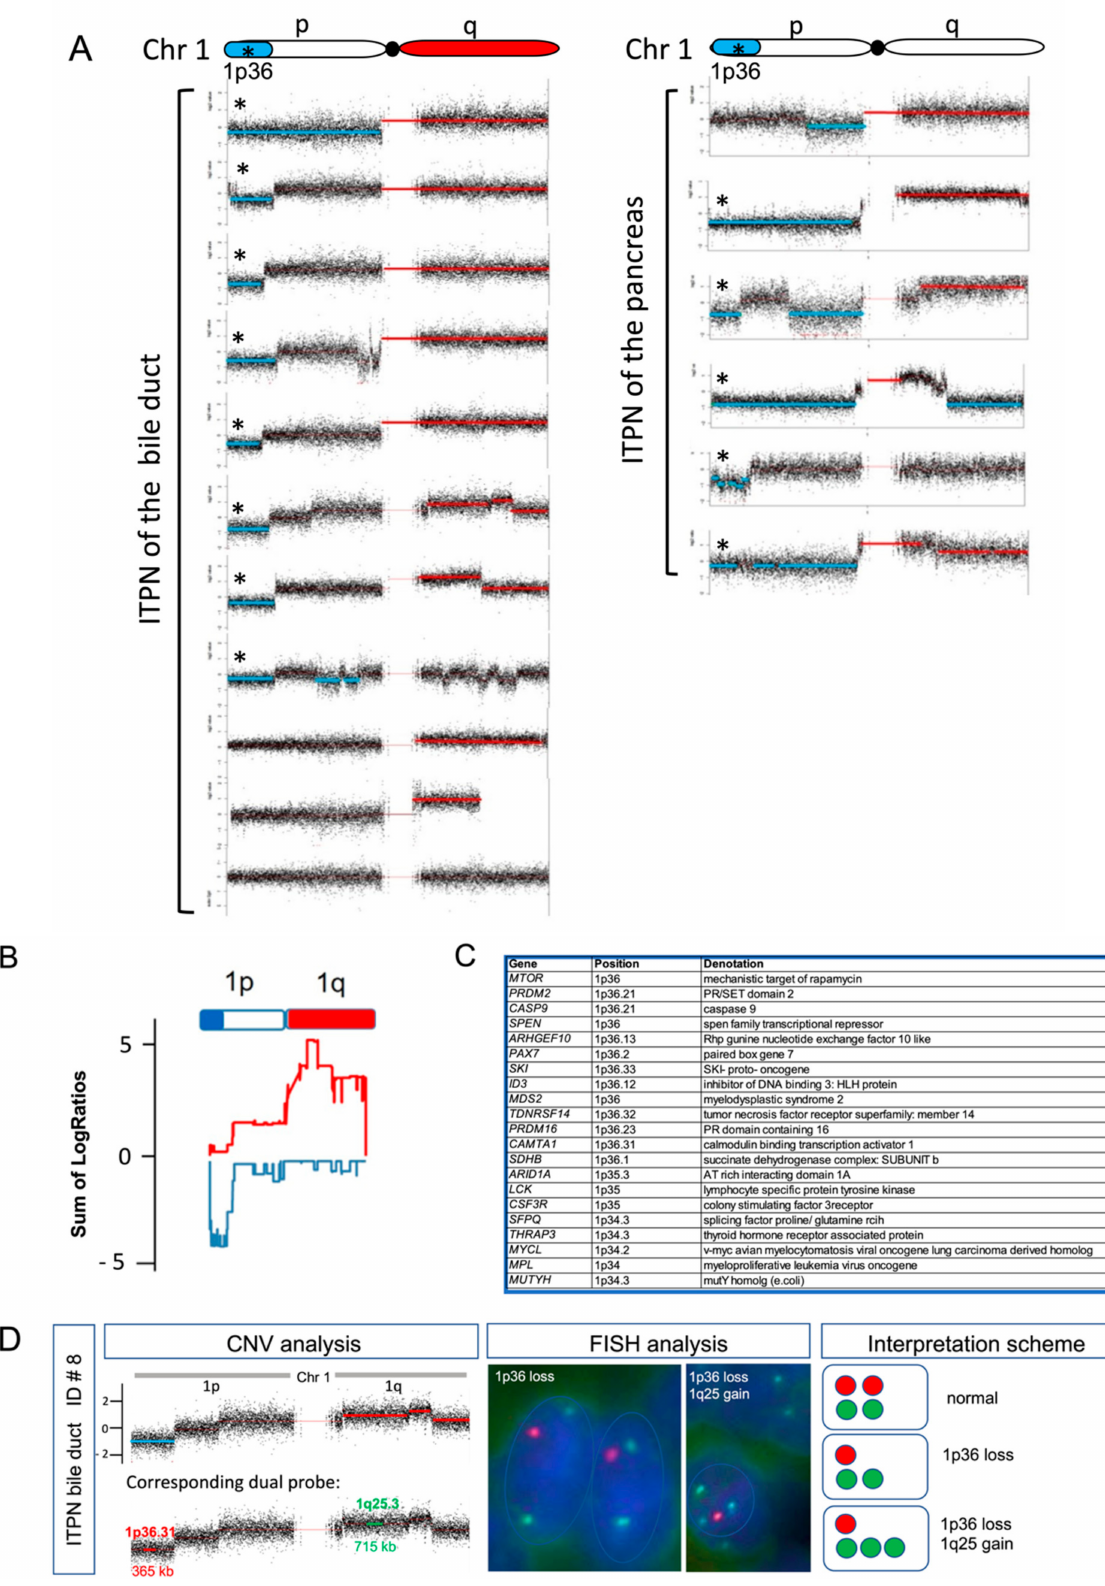
Figure 6. Recurrent chromosomal aberrations on chromosome 1 identified by CNV analysis. Individual plots of chromosome 1 of all cases ( A ). Deleted fragments of chromosome 1 are shown in blue (LogRatio ≤ − 0.2), and amplifications are highlighted in red (LogRatio ≥ 0.2). Deletions were predominantly located at the telomeric 1p36 region (*), amplifications on 1q. Overlay-plot of chromosomal gains (red) and losses (blue) of all ITPNs ( n = 17) ( B ). Gains and losses are